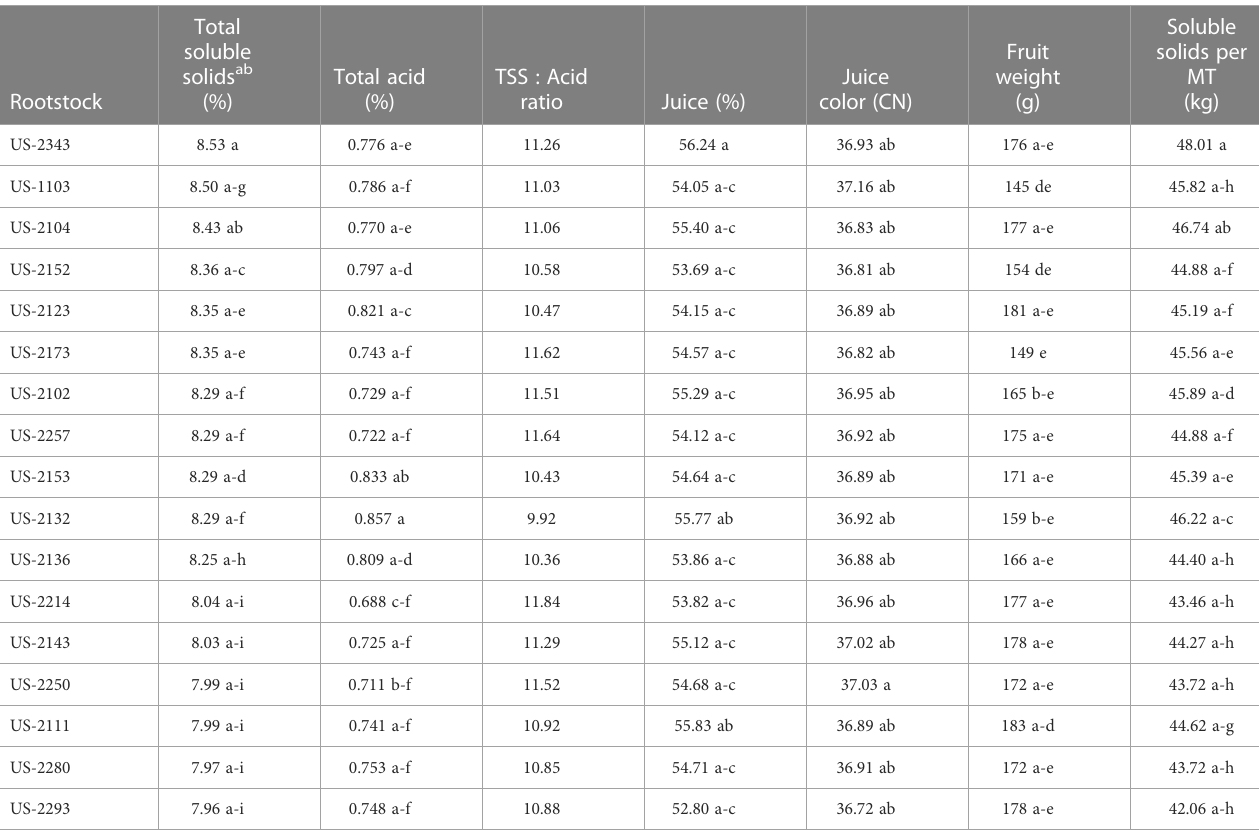
TABLE 4 Fruit quality for the 2019-21 harvest